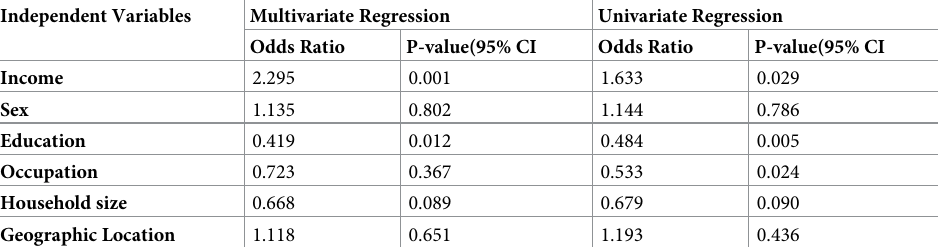
Table 5. Result of logistics multivariate regression analysis.